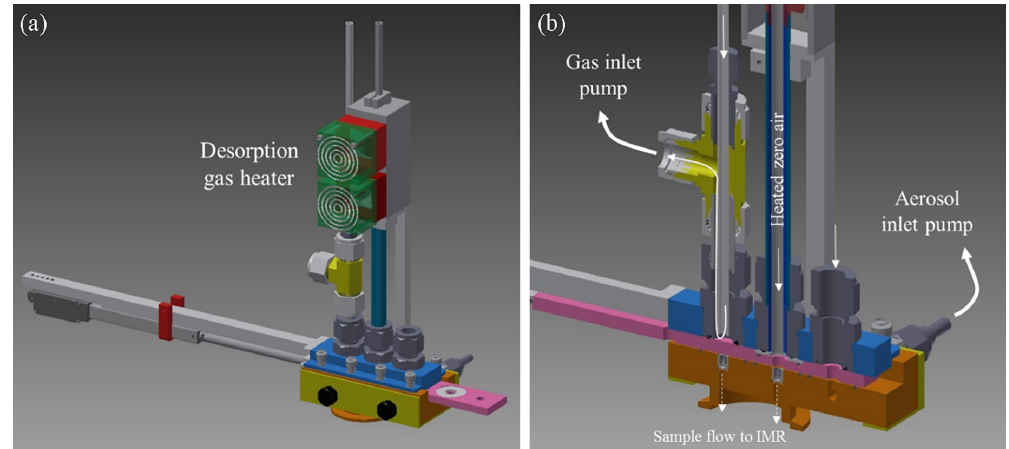
Figure 1. Drawing of the ARI FIGAERO assembly. Panel (a) shows the full assembly with a mechanical actuator that controls gas sampling and aerosol collection or aerosol desorption operating modes. Panel (b) is a cross-sectional view that show flows for both gas and particle sampling mode and the two apertures that connect with the IMR. In this view the FIGAERO slide is positioned in the aerosol desorption mode, and the gas sample flow into the IMR is closed.